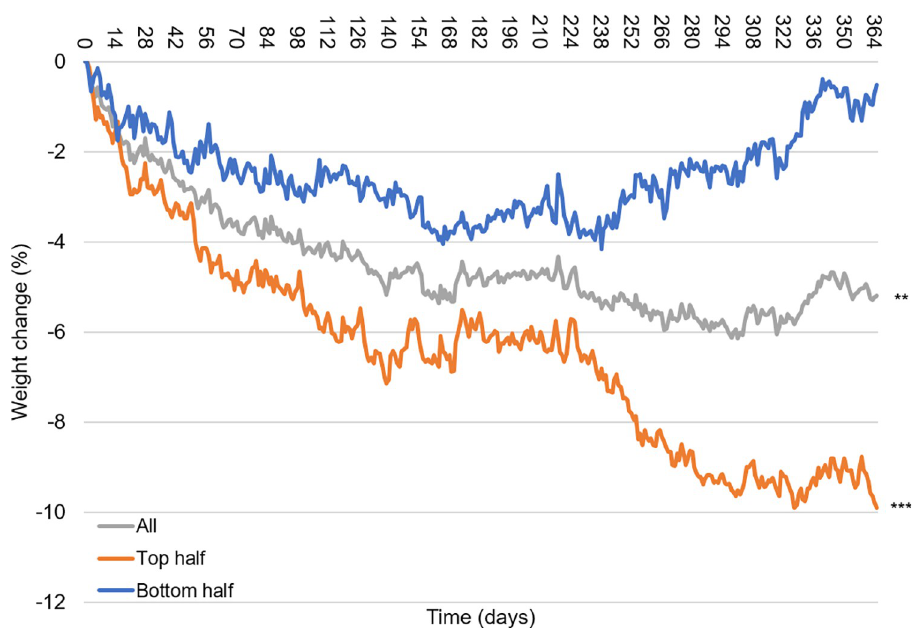
Fig 5. Weight changes (%) of all, top-half and bottom-half groups over 12 months. Participants were divided into two groups of equal size (n = 6 each) based on the weight changes from baseline at 12 months. �� p < 0.01, ��� p < 0.001 at 12 months compared with